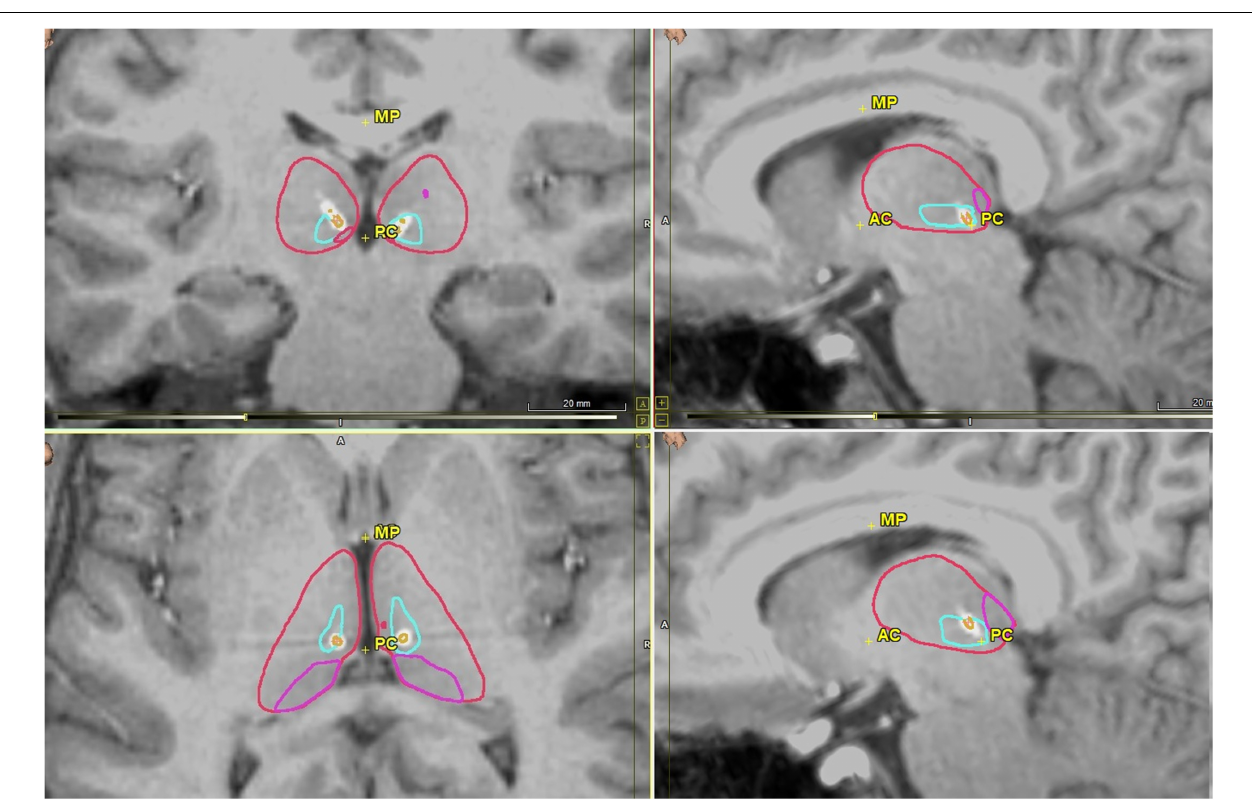
FIGURE 2 | Postoperative CMT nuclei images in coronal (upper left), axial (bottom left) and sagittal views (upper and lower right) with RNS electrodes visualized. CMT is outlined in light blue, thalamus in red, pulvinar in pink, and electrode in white with each contact in orange. Images generated using WayPoint Navigator version